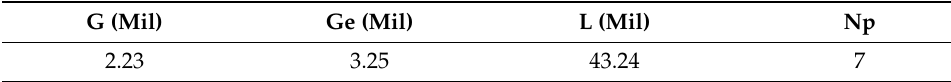
Table 10. Test data of interdigital capacitor.